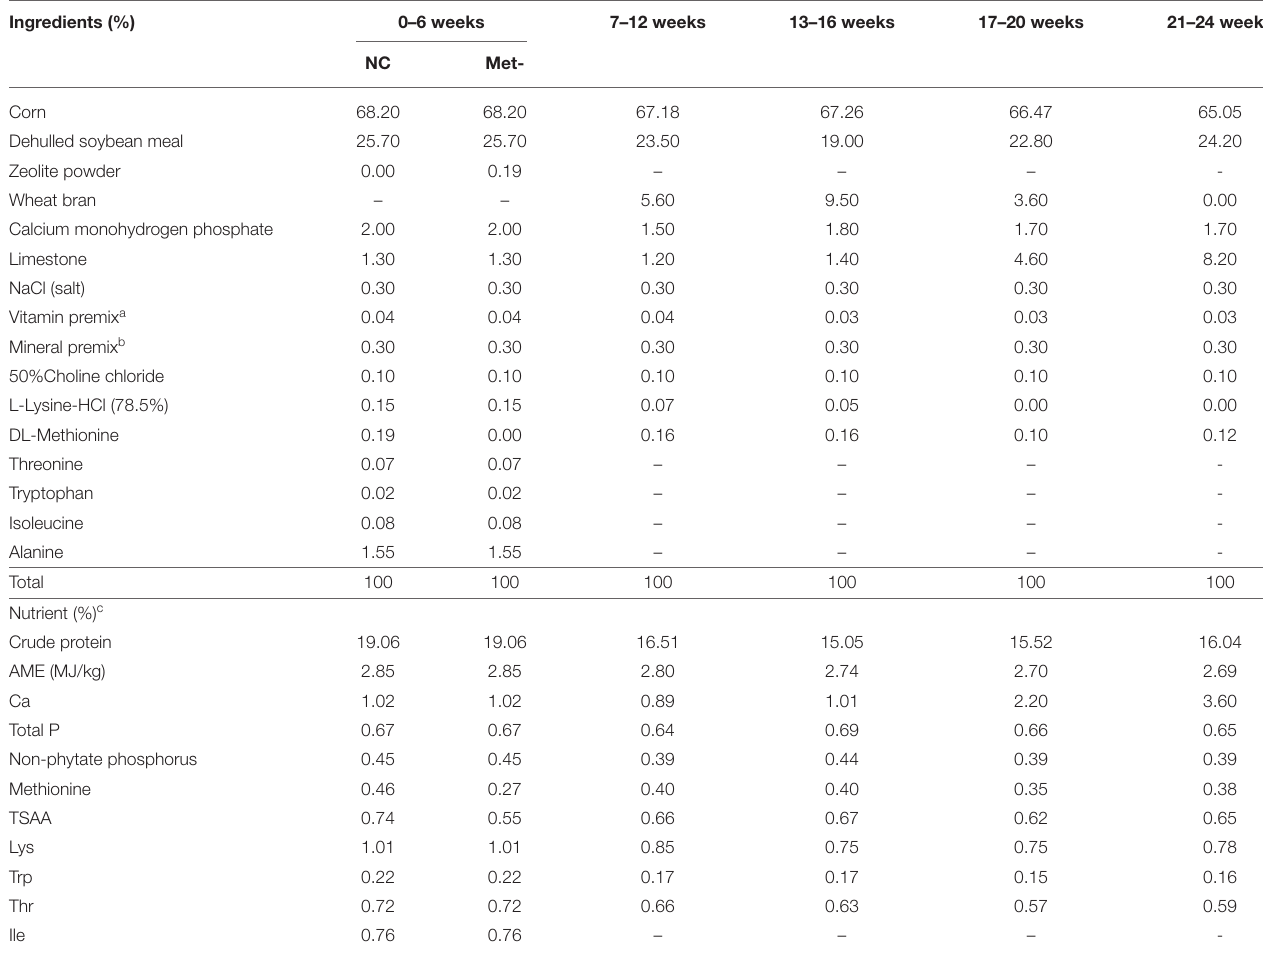
TABLE 1 | Ingredients and nutrient content of the diets (%